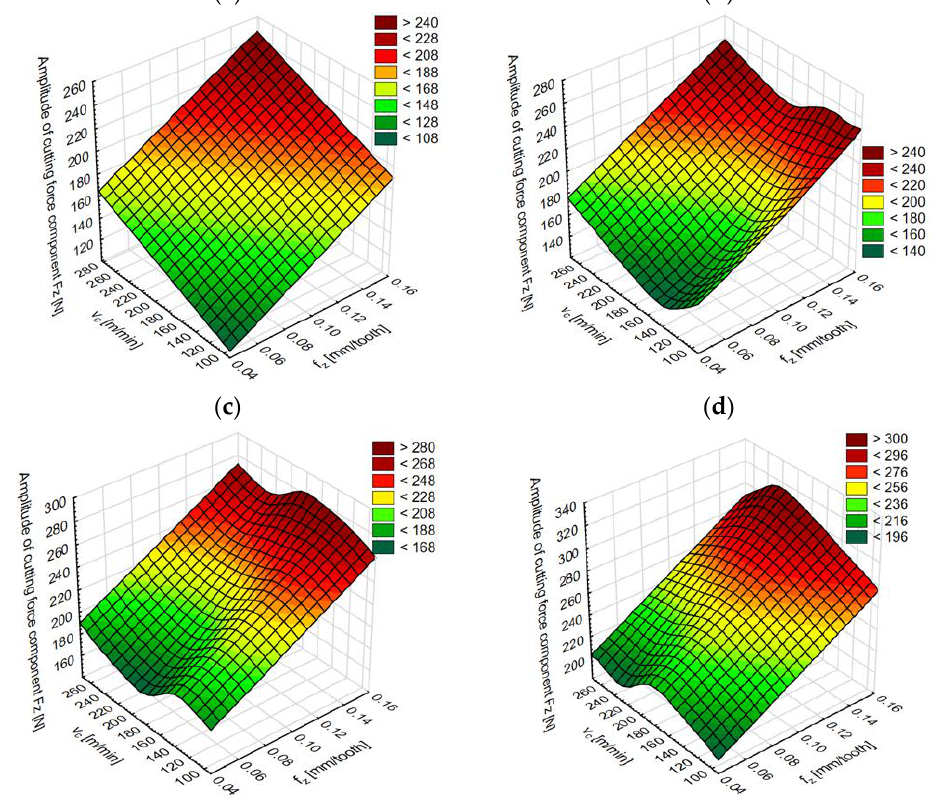
Figure 16. Network performance results of the MLP 3-2-1 for the materials: ( a ) A1, ( b ) A2, ( c ) B1, ( d ) B1.